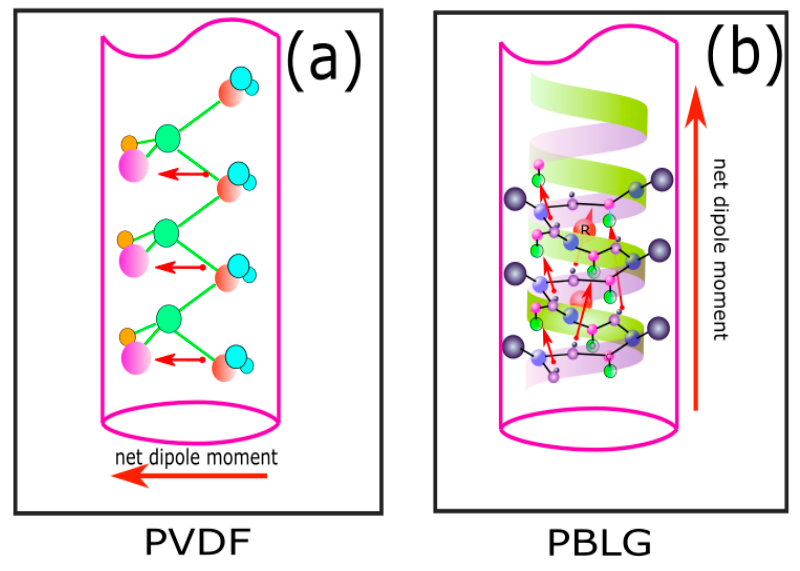
Figure 1. The orientation of the dipole moment (red arrows) in ( a ) an electrospun PVDF fiber and ( b ) an electrospun PBLG fiber. The net dipole moment reveals the largest polar direction in which the piezoelectric coefficient of a material is the largest.